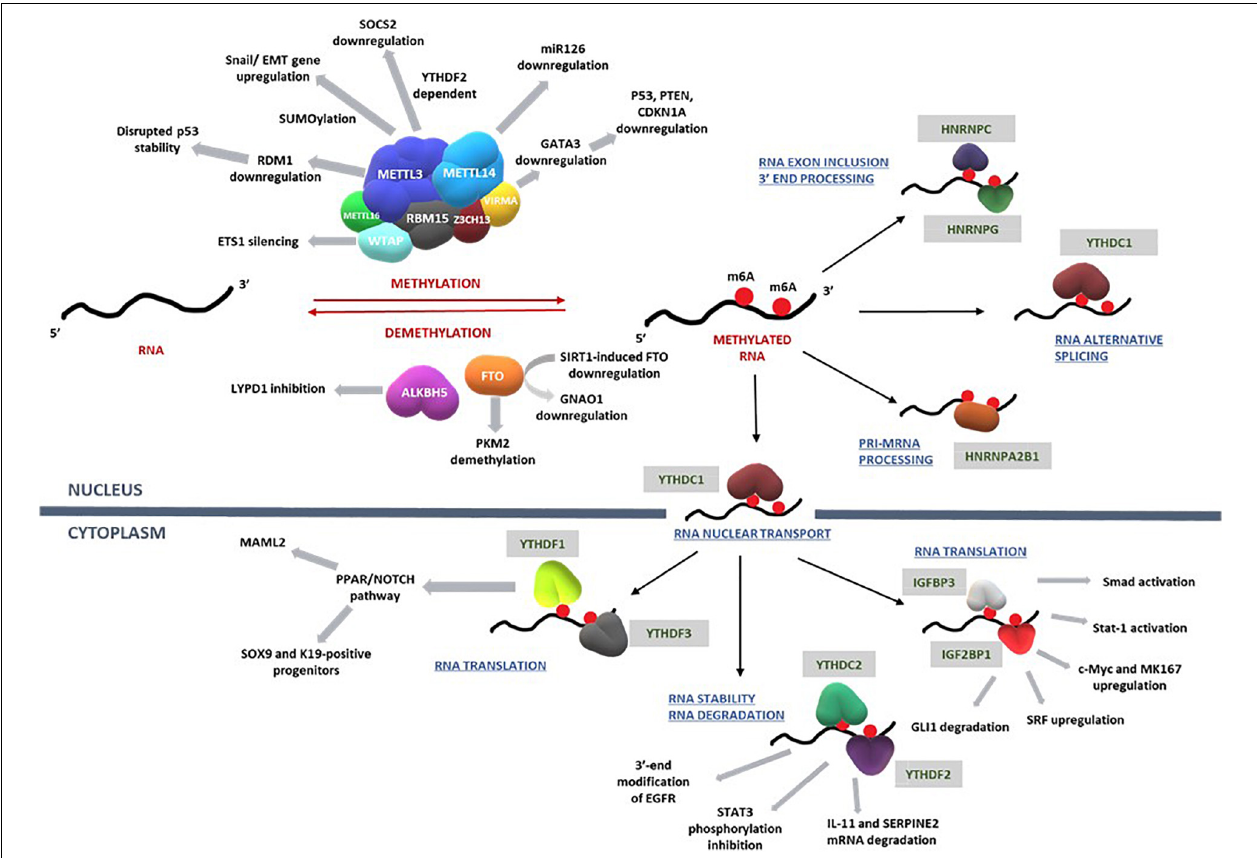
FIGURE 3 | RNA methylation on transcripts induces a spectrum of intracellular mechanisms that are primarily driven by methylases, demethylases, and RNA binding proteins. Such mechanisms regulate RNA translation, nuclear transport, degradation, exon inclusion 3 (cid:48) -end processing, and alternative splicing. Deregulation of these complex network of mechanisms involving key signal transduction pathways that govern cell cycle, proliferation, differentiation, and apoptosis eventually influence the progression of hepatocellular carcinoma. Refer to Table 1 for information on the regulatory patterns of m6A regulators with regard to HCC. Figure modified from Karthiya and Khandelia